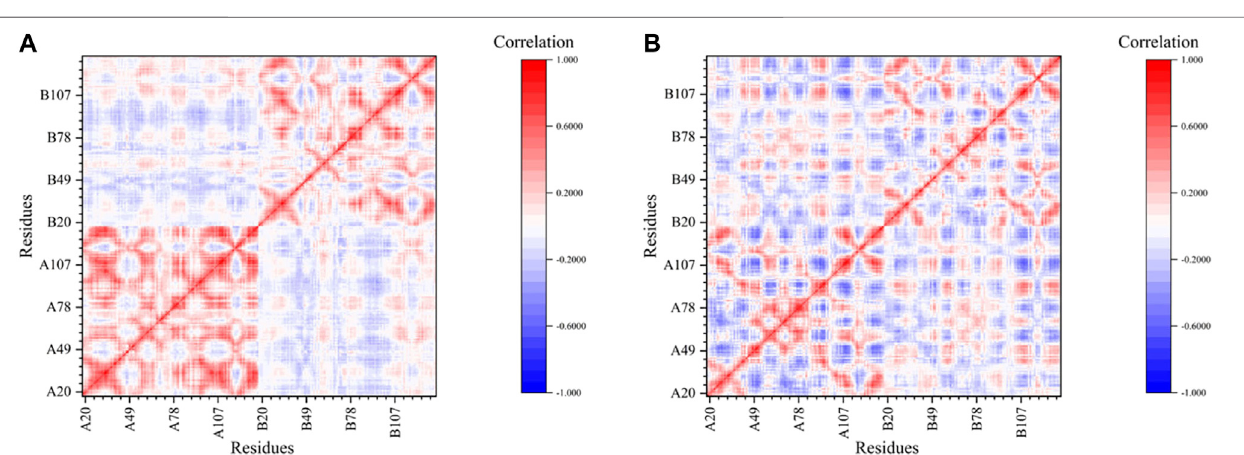
Frontiers in Chemistry |